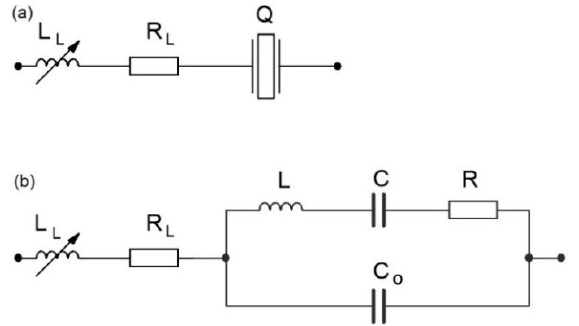
Figure 1. ( a ) The real inductance L L + R L in series with the quartz crystal and ( b ) the real inductance L L + R L with the quartz crystal equivalent circuit.